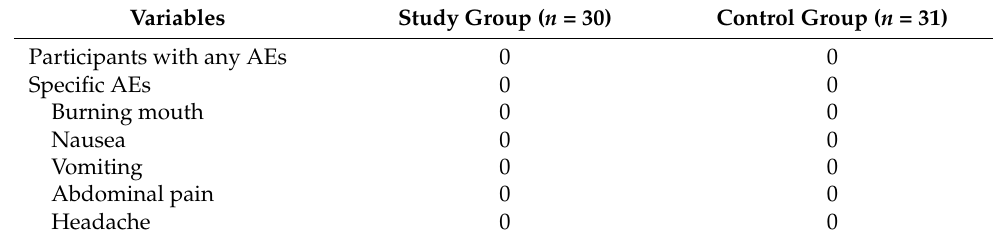
Table 3. Summary of adverse